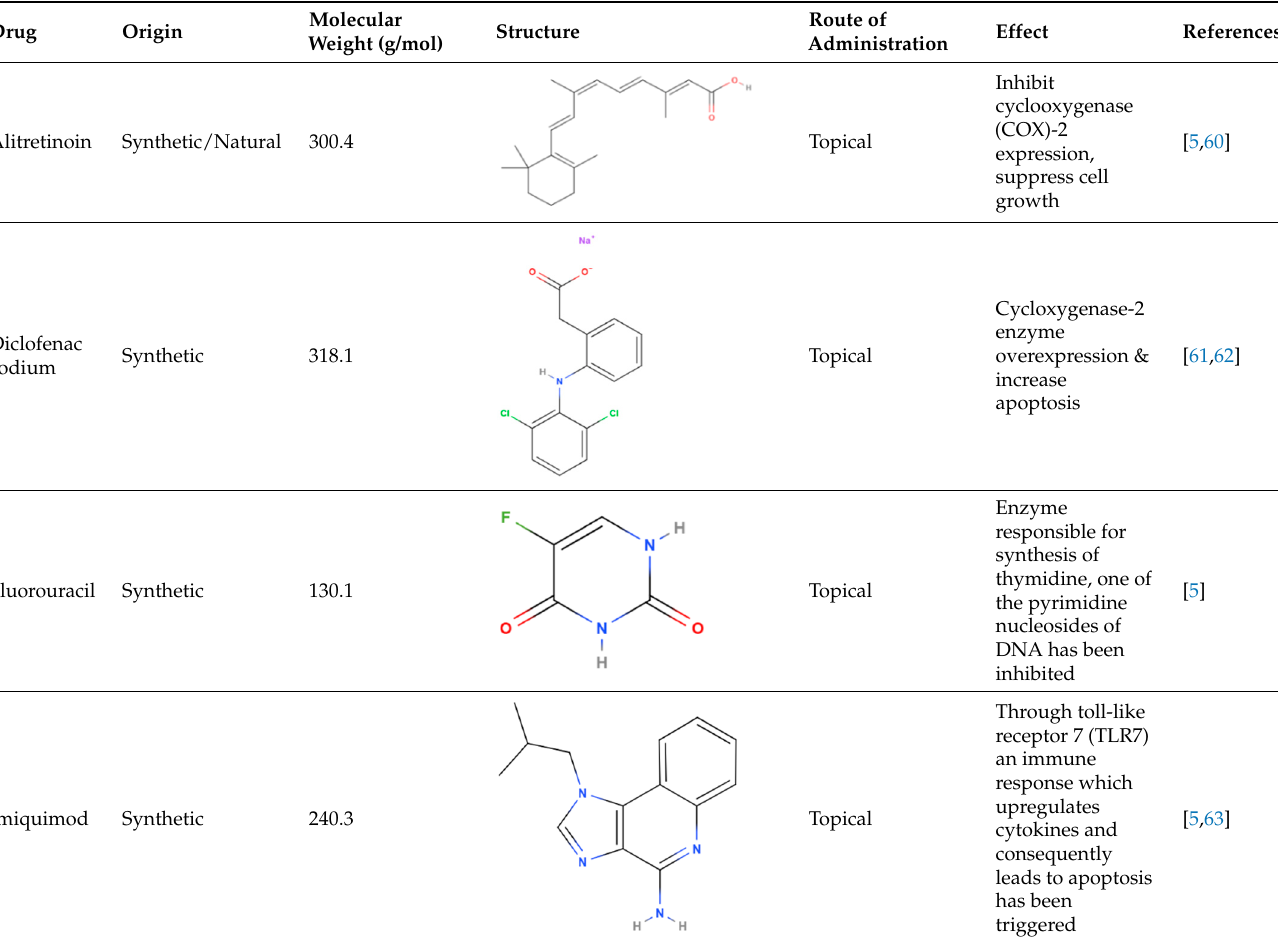
Table 2. Current drugs used for skin cancer.